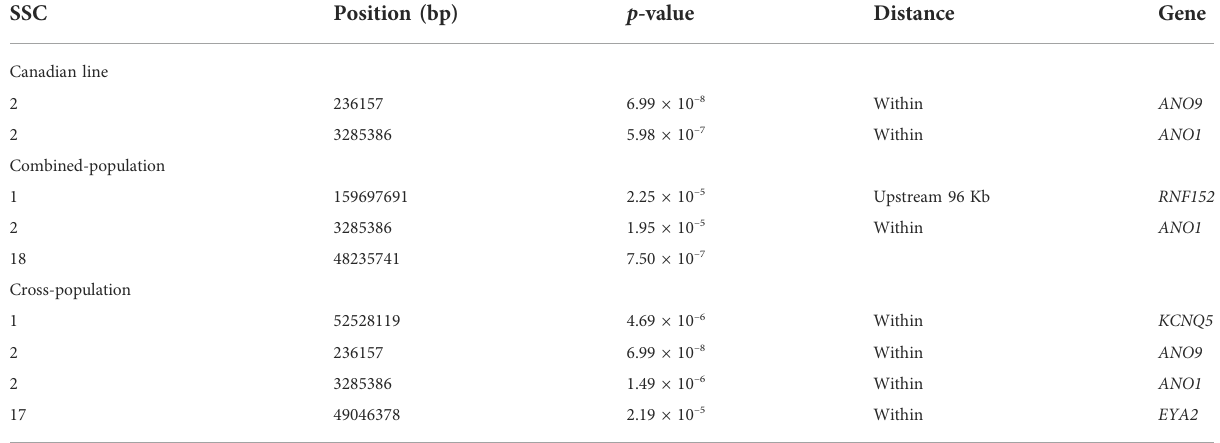
TABLE 3 Signi fi cant SNPs and genes in which they are located identi fi ed in the genome-wide association study for BF100 trait. SSC p